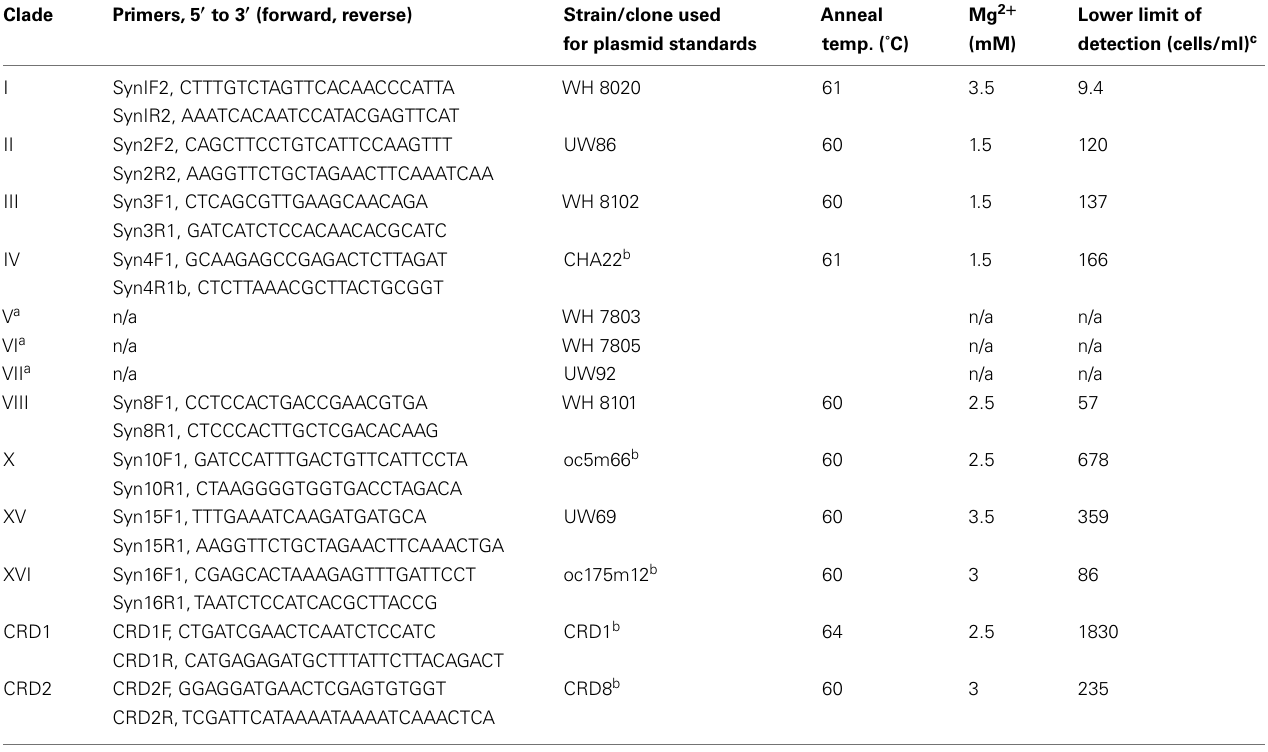
Table 1 | Primers, plasmid standards, and optimized reaction and cycling conditions used for qPCR assays. Clade Primers, 5 (cid:2) to 3 (cid:2) (forward, reverse)